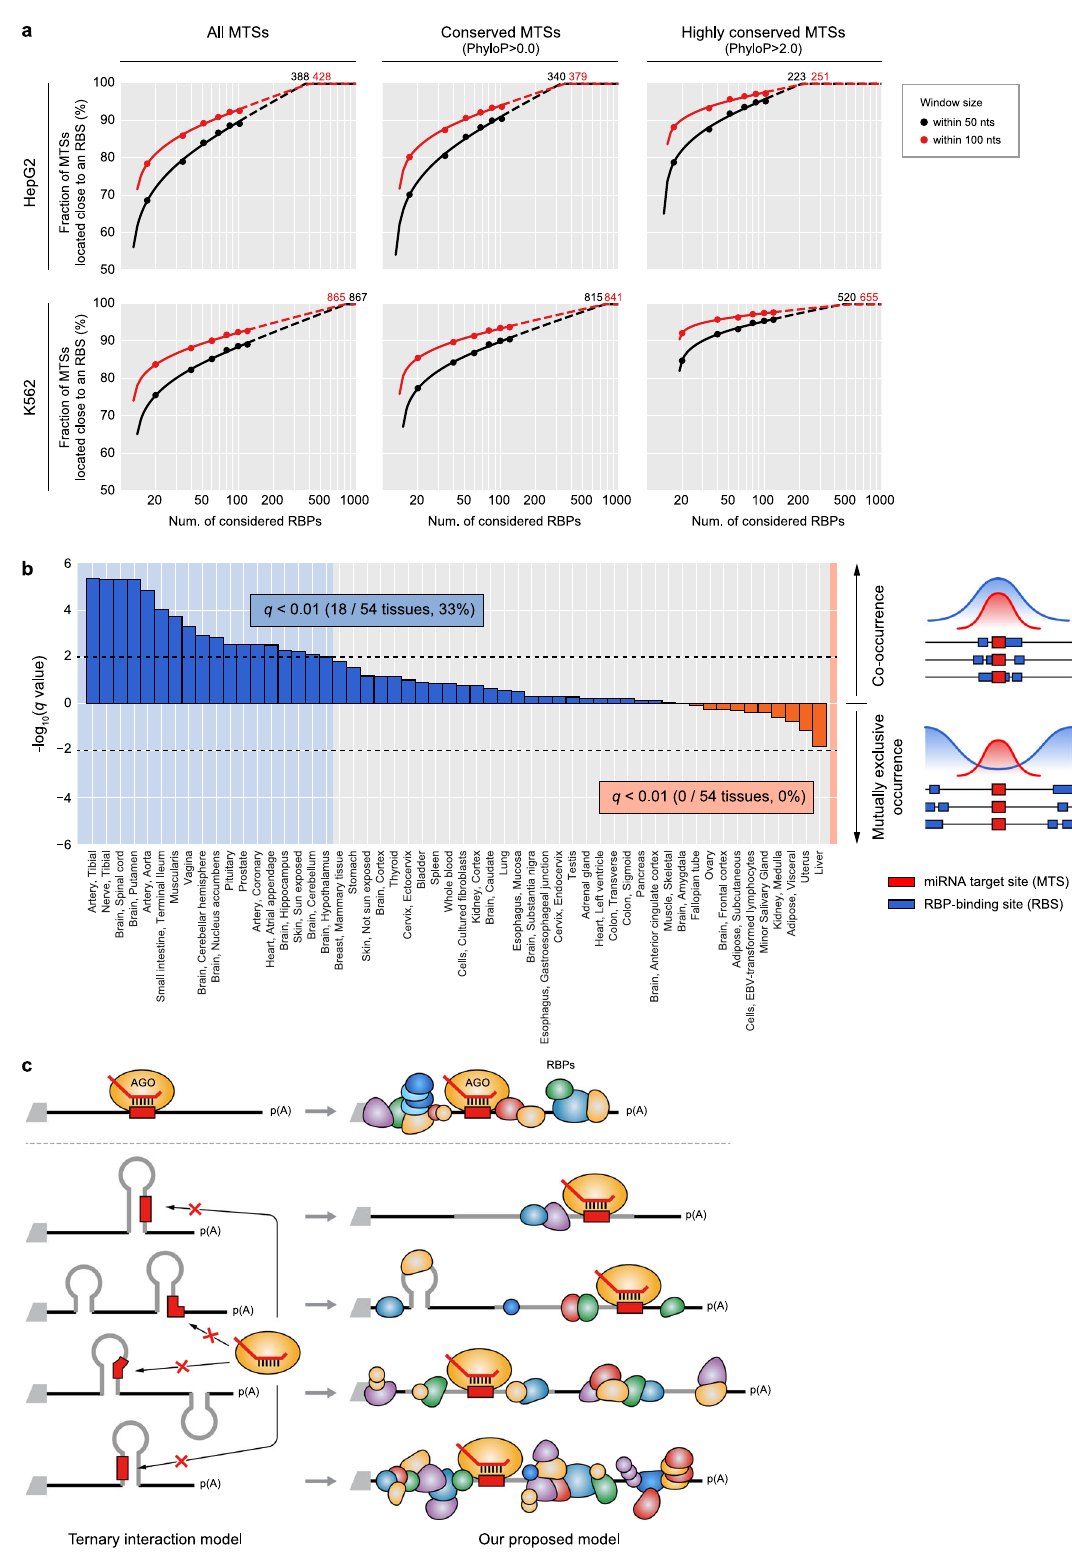
miRNA assay (Applied Biosystem). The qPCR was performed with LightCycler II 480 v.1.5.1 (Roche) following the manufacturer ’ s protocol. The Ct values of IP samples were normalized to those of each input sample using the following